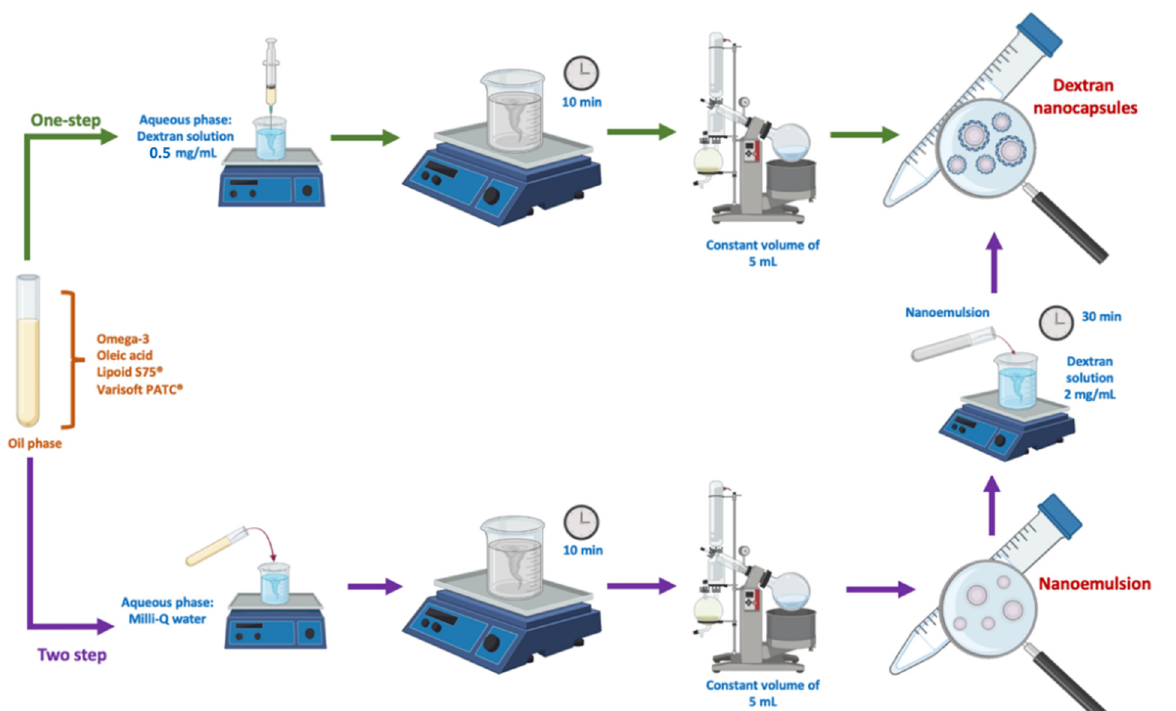
Figure 1. Process of the elaboration of the nanosystem. Created with BioRender.com (accessed on October 2022).